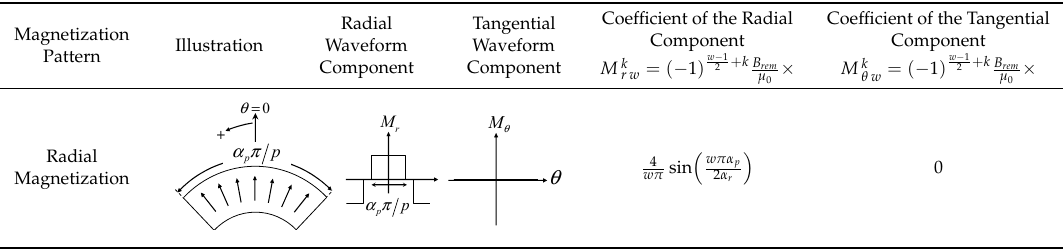
Table 2. Radial magnetization pattern and its Fourier series components.